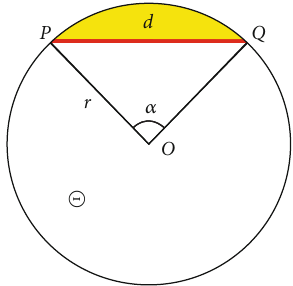
Figure 2: Schematic diagram of the spherical arch